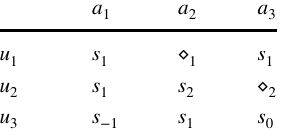
Table 3 FLC ( U , A , S ∗ , R ∗ )